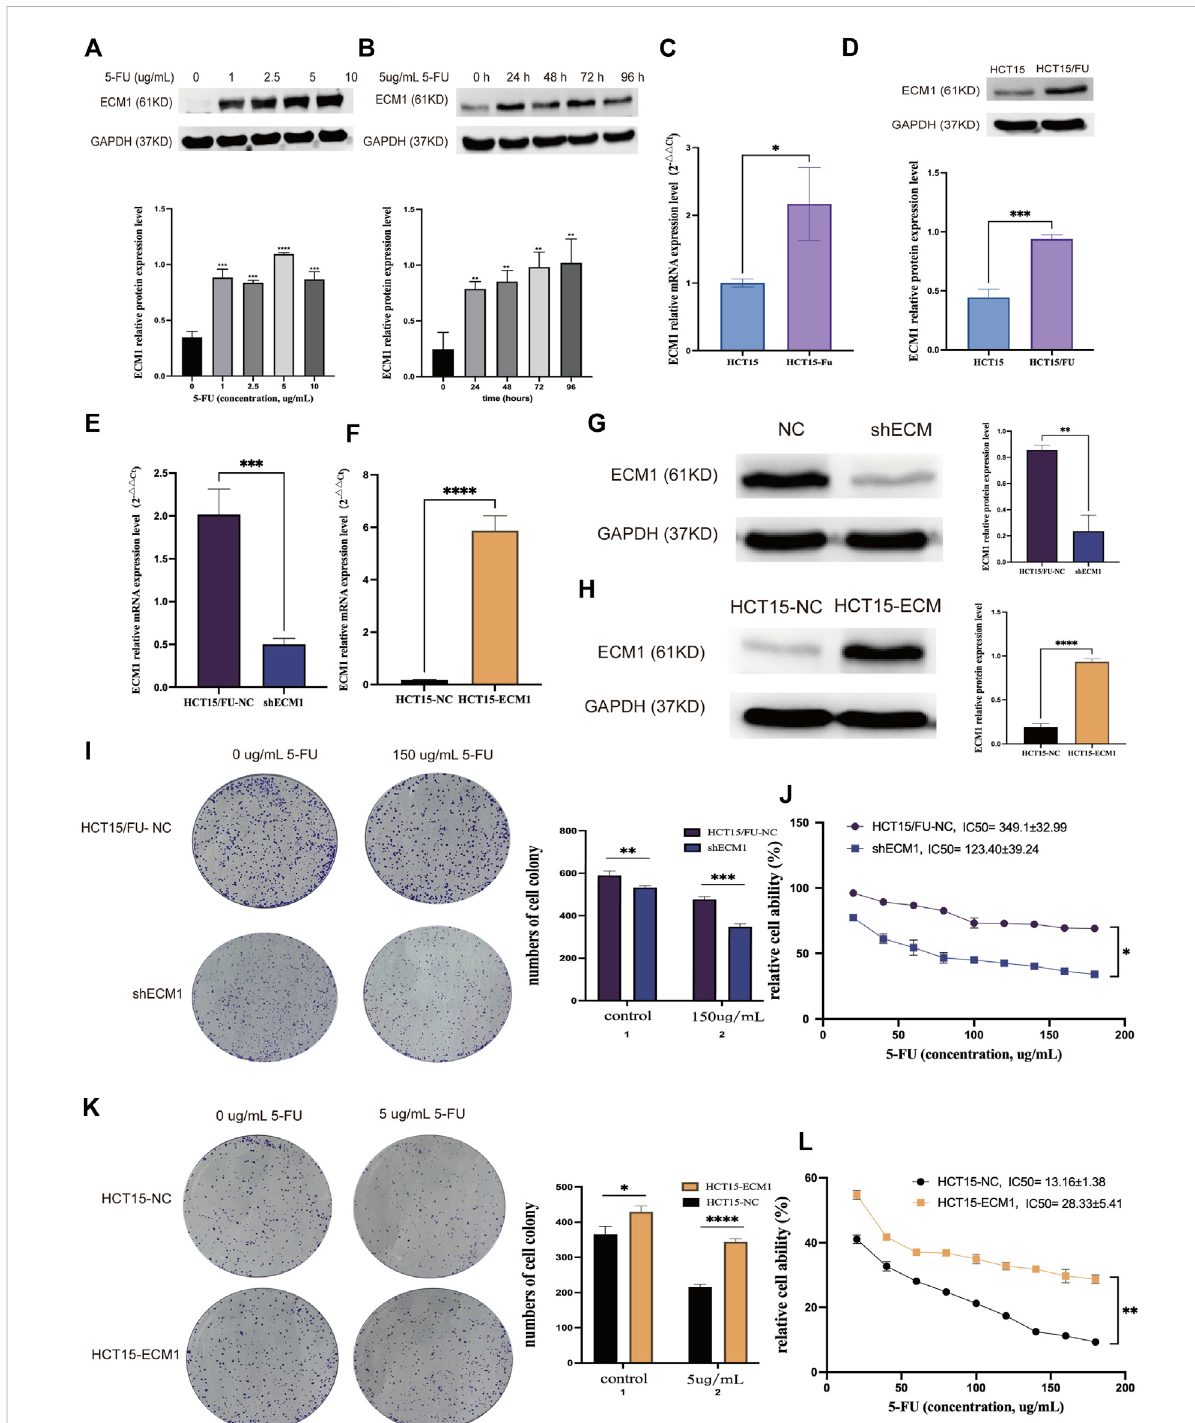
FIGURE 2 ECM1 isinvolved in5-FUresistance inCRC cells. (A) Aftertreatment for24 hwitharangeof5-FUdoses (0,1,2.5,5,or10 µg/ml),ECM1 levels in HCT15 cells were detected via Western immunoblotting. (B) After treatment for 24, 48, 72, or 96 h with 5 µg/ml of 5-FU, ECM1 protein levels in HCT15 cells were detected via Western immunoblotting. (C,D) qPCR and Western immunoblotting approaches detected ECM1 levels within HCT15 and HCT15/FU cells. (E – H) Western immunoblotting and qPCR were used to evaluate the ef fi cacy of ECM1 overexpression or knockdown. Through CCK-8 and colony formation tests, the susceptibility of these cells to 5-FU was further examined. (I,J) The effects